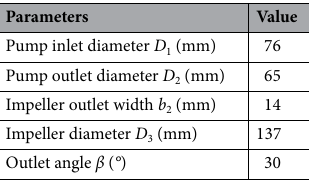
Table 1. Main geometric parameters of booster pump.